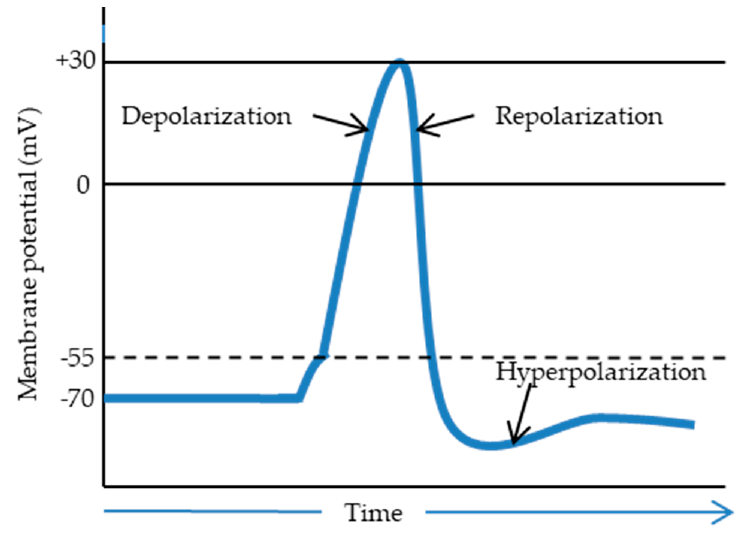
Figure 4. Potential di ff erence in neural transmission as a function of time (adapted from [69]). Signal transmission is the integral objective of neurons; hence, they are influenced by electrical stimuli. Many research groups have tried to explain the e ff ect of electric stimulation on nerve regeneration. One group described the general e ff ect of electrical stimulation on neurons [70]. Another group studied the activation of the growth controlling transport processes across the plasma membrane and the electrophoretic accumulation of the surface molecules responsible for neurite growth or cell substratum adhesion [70]. Freeman et al. [71] suggested that changes in ionic currents comprise a possible phenomenon that can a ff ect nerve cells, while another thesis [72] described the e ff ect of electrical stimulation on the synthesis of protein and stimulation of the neurite outgrowth in vitro. Furthermore, the authors in [73] postulated that pheochromocytoma in rat neuronal cells (PC12 cells) was electrically activated, while in [74], it was shown that the electrical stimulation increased the adsorption of fibronectin, which explains the enhanced neurite extension on electrically stimulated polypyrrole films. Additionally, nerve cells in the presence of electrical stimulation showed an extensively elongated morphology. In general, tensile / compression forces acting on the piezoelectric sca ff olds generate the electrical stimulation and transfer it to the surrounding cells, promoting the cell signaling pathways, responsible for growth factor synthesis (Figure 5)